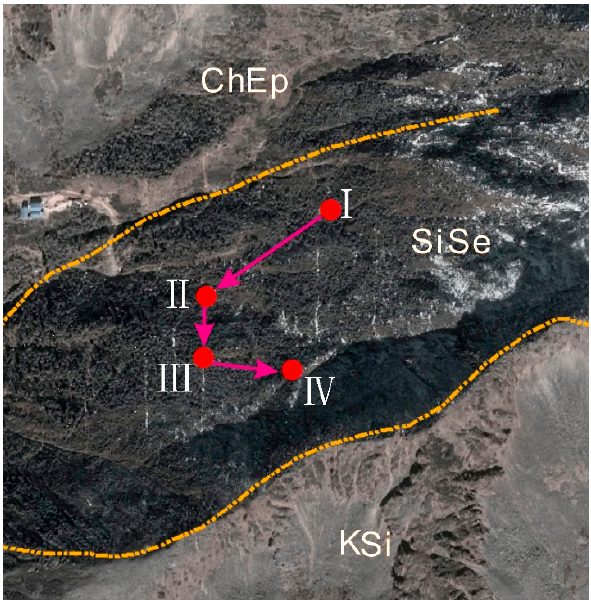
Figure 9. Analysis diagram of correlation between the four drillings and the new alteration zoning. I–IV: drilling numbers; KSi: potassic-silicification zone; SiSe: phyllic zone; ChEp: propylization